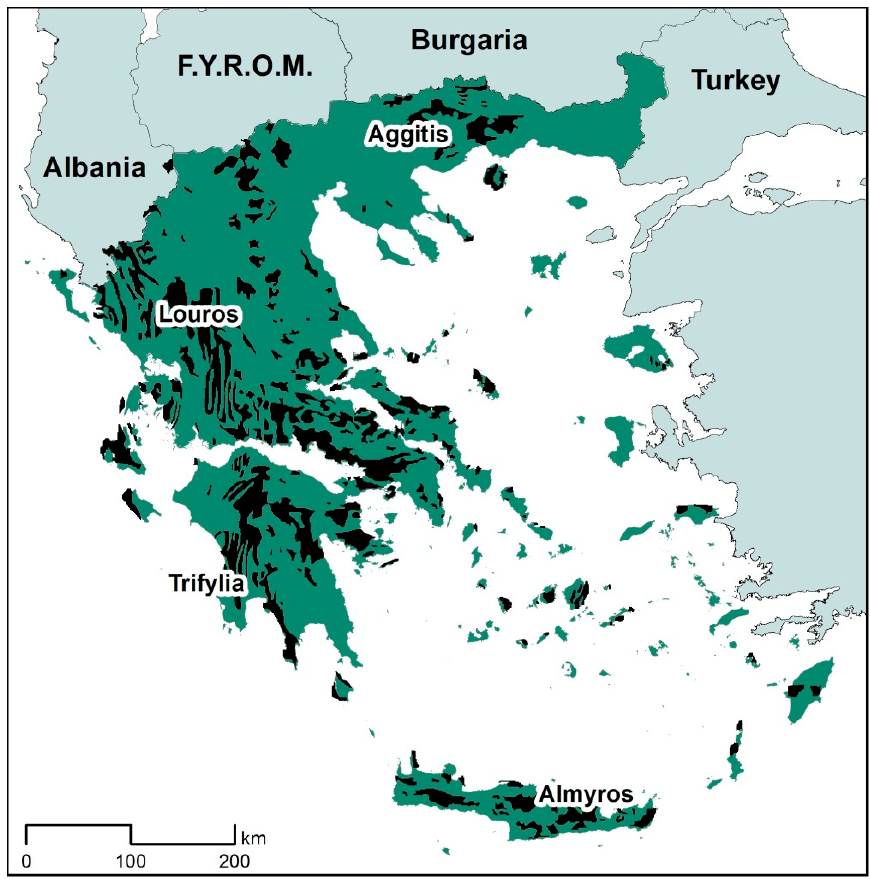
Figure 2. Map showing the Hellenic karst systems (modified from [38]).